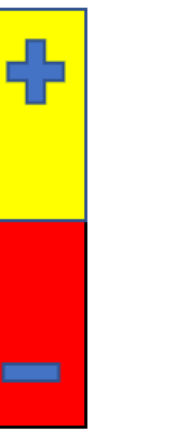
Figure 1. Antisymmetric combination.